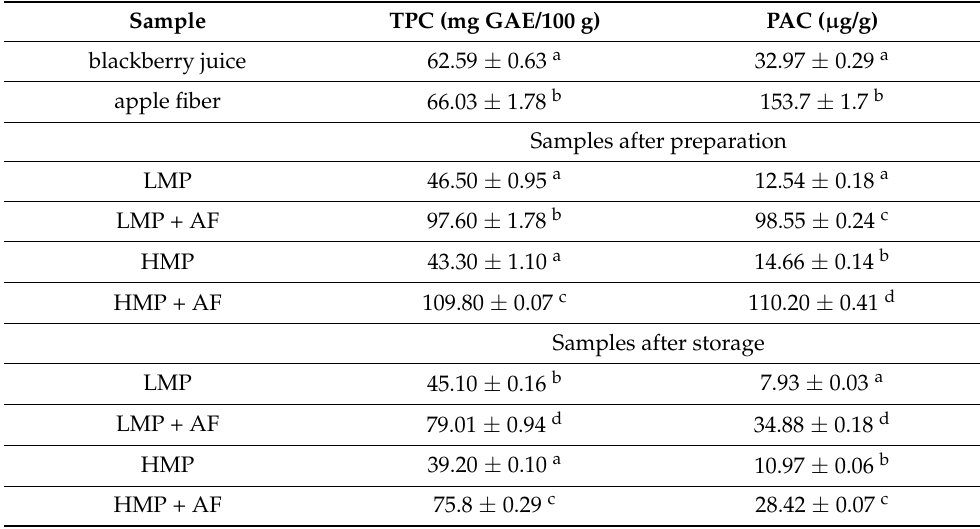
Table 1. Concentration for total phenolics (TPC) and proanthocyanidins (PAC) of hydrogels after preparation and after